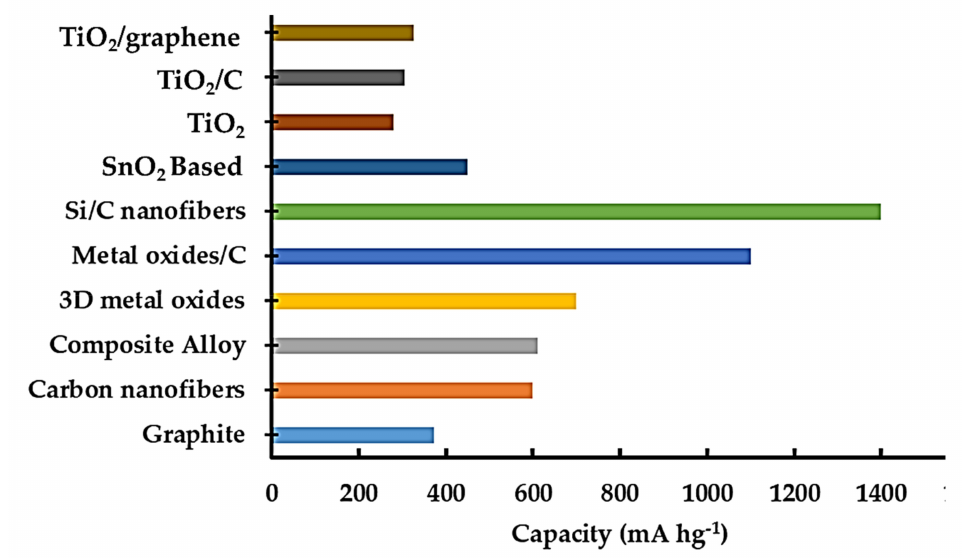
Figure 2. The reversible capacities of different LIB anode materials.